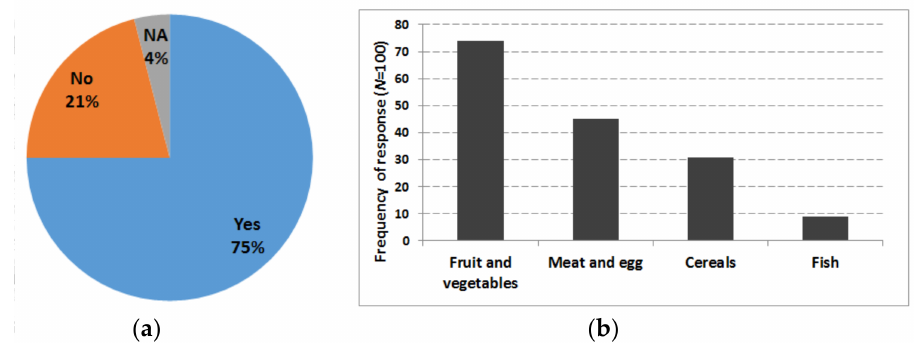
Figure 7. Expenditure on organic food and purchasing frequency. ( a ) Spending >14 € on organic produce per each purchase of food; ( b ) frequency of purchasing different organic